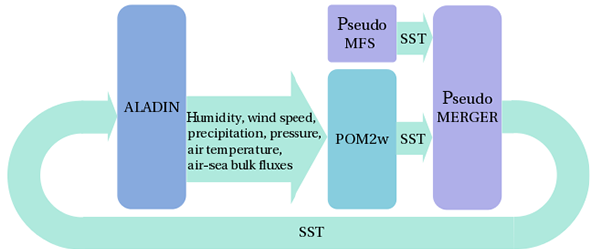
Figure 2. Two-way atmosphere–ocean coupling scheme for one coupling time step. Rounded rectangles denote distinct OASIS models, effectively treated by OASIS as independent. The arrows denote exchanged coupling quantities and direction of the transfer. Time instant of any specific coupling exchanges within one cou- pling time step grows from left (earliest) to right (latest).